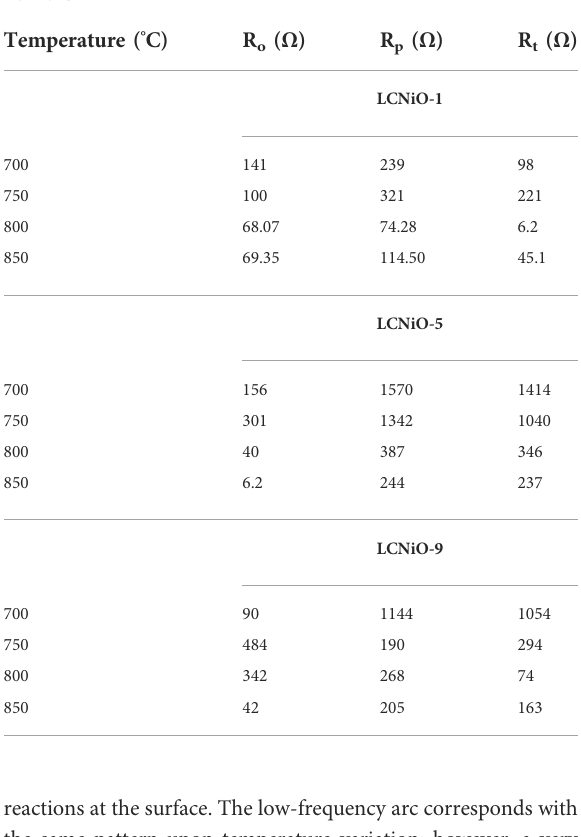
TABLE 2 Different resistances calculated from simulation of HT-EIS data for three-layered cell based on LCNiO-1, LCNiO-5, and LCNiO-9.